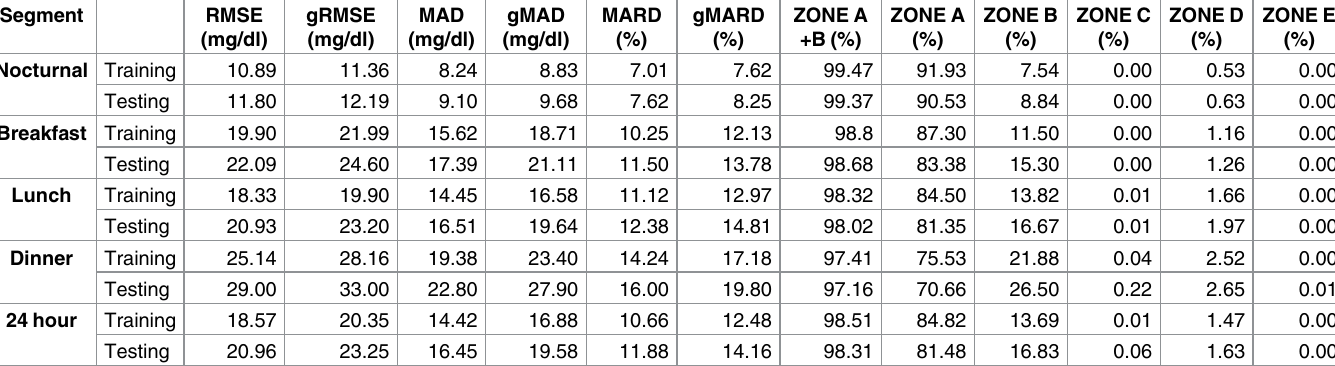
Table 2. Mean values of the performance metricsfor 100 patients to fit 6-h prediction